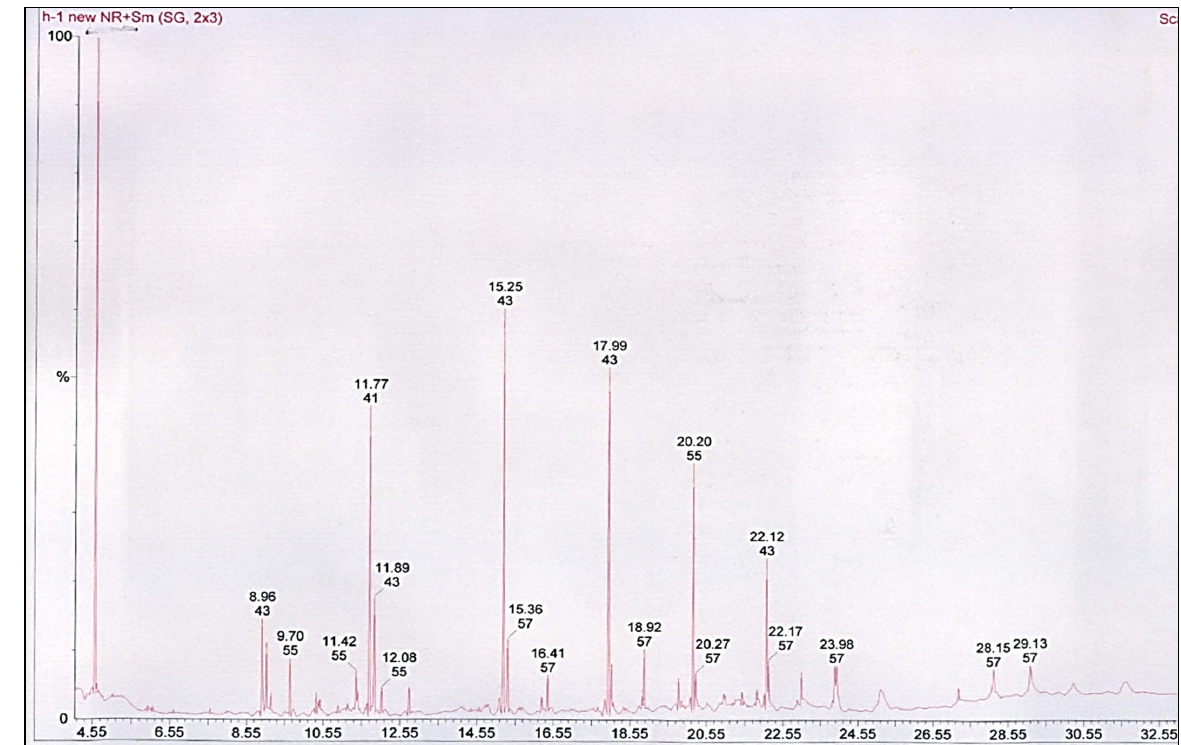
Figure 5. GC–MS chromatogram for EtOAc extract of Streptomyces sp. strain ess_amH1.